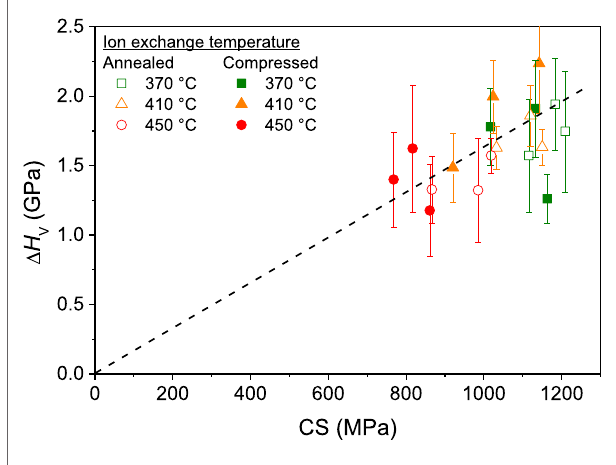
FigUre 9 | Vickers hardness ( H V ) as a function of density ( ρ ) for the annealed (open symbols) and compressed samples (filled symbols) before ion exchange (gray symbols) and after ion exchange (colored symbols) . Inserted labels denote the treatment prior to ion exchange, i.e., applied isostatic pressure or annealing duration.